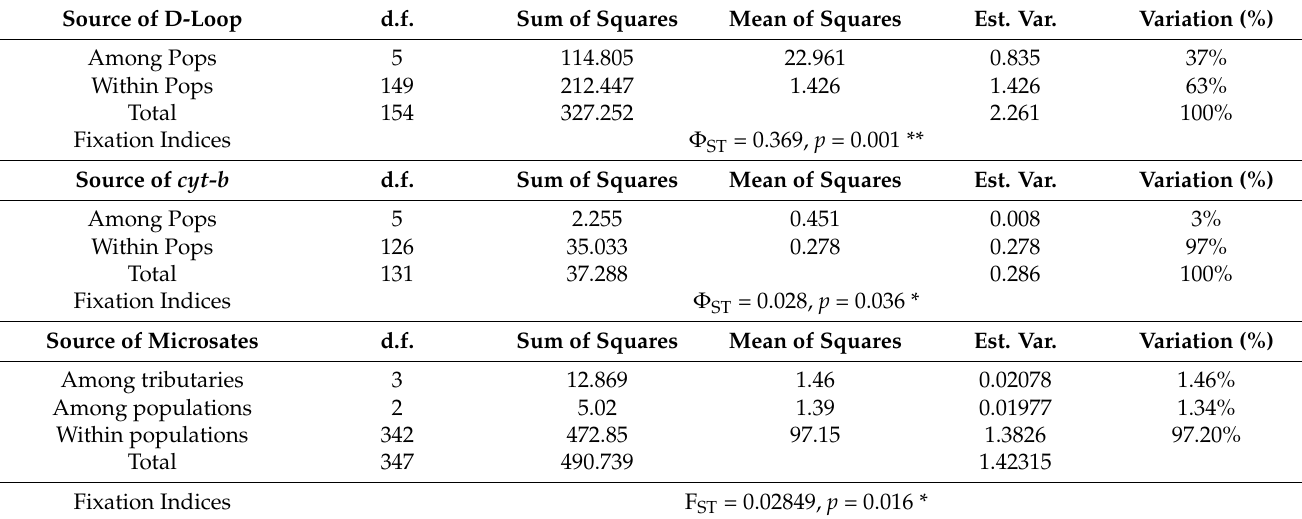
Table 3. AMOVA analysis of 6 populations based on D-loop and cyt b sequences.